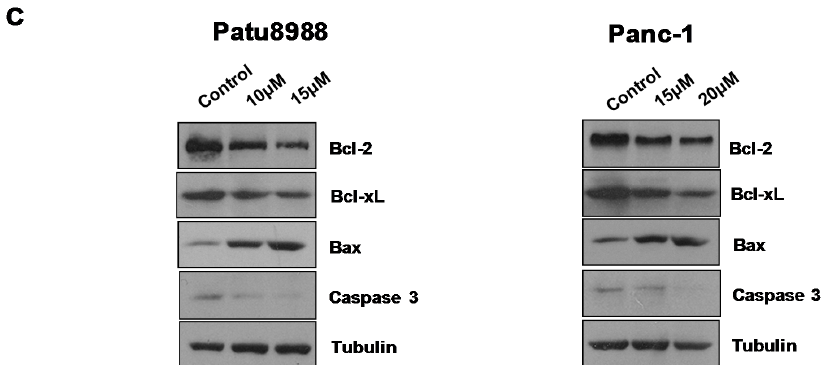
Figure 2. Overexpression of Cdc20 decreased curcumin-induced cell growth inhibition and apoptosis. ( A ) A 3-(4,5-dimethyl-2-thiazolyl)-2,5-diphenyl-2-H-tetrazolium bromide (MTT) assay was performed to measure the cell growth in PC cells with Cdc20 cDNA transfection in combination with curcumin treatment. * p < 0.05, compared with control; # p < 0.05 compared with curcumin treatment or Cdc20 cDNA transfection alone; ( B ) Cell apoptosis was determined by flow cytometry in PC cells treated